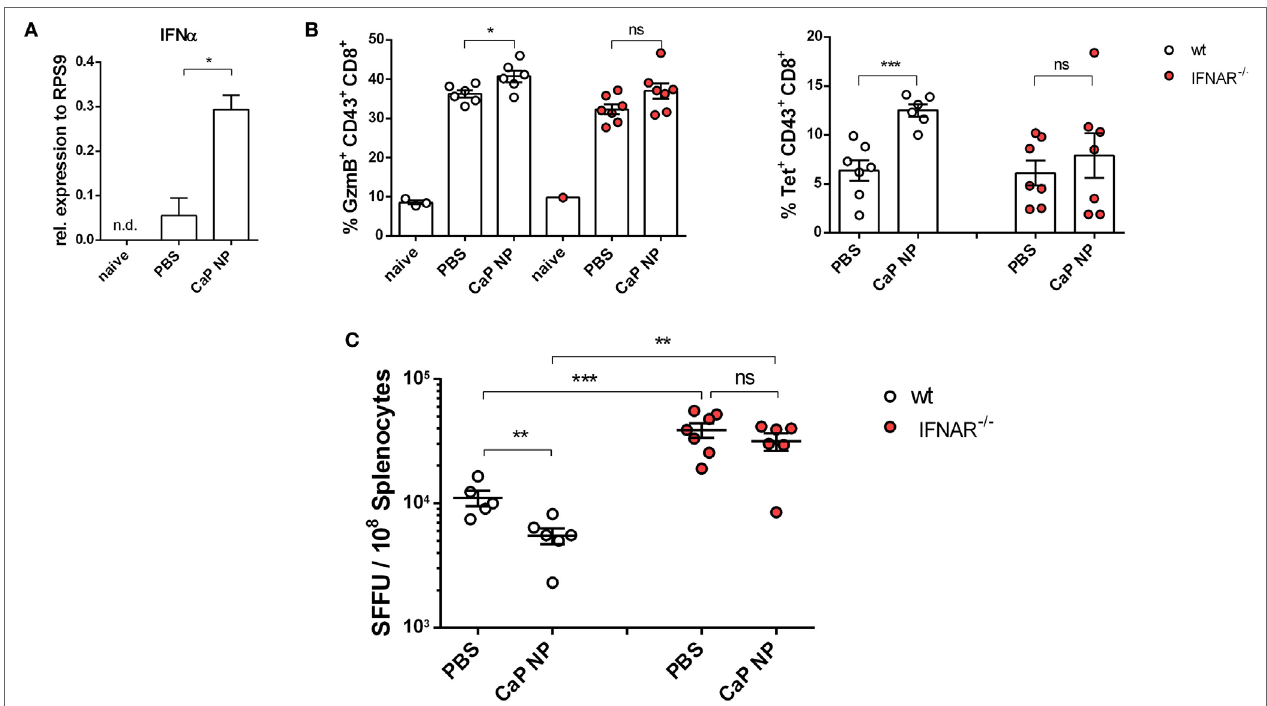
FigUre 4 | Diminished reactivation of cytolytic CD8 + T cells after therapeutic vaccination of chronically infected IFNAR − / − mice. (a) Chronically infected C57BL/6 mice were vaccinated subcutaneously either with phosphate-buffered saline (PBS) or CpG and FV peptide functionalized calcium phosphate (CaP) nanoparticles (NPs). 7 days postvaccination RNA was isolated from splenocytes and expression of IFN α was analyzed by quantitative real-time PCR. (B) Splenocytes were isolated 7 days postvaccination from non-infected naïve wt or chronically infected wt and IFNAR − / − mice and stained for granzyme B expression in CD43 + CD8 + T cells and tetramer + FV-specific CD43 + CD8 + T cells. (c) Infectious centers in the spleen were determined 7 days postvaccination. The results of two independent experiments are shown, n = 6–7. Bars represent mean ± SEM. Statistical analysis was performed by Student’s t -test (* p < 0.05; ** p < 0.01; *** p <